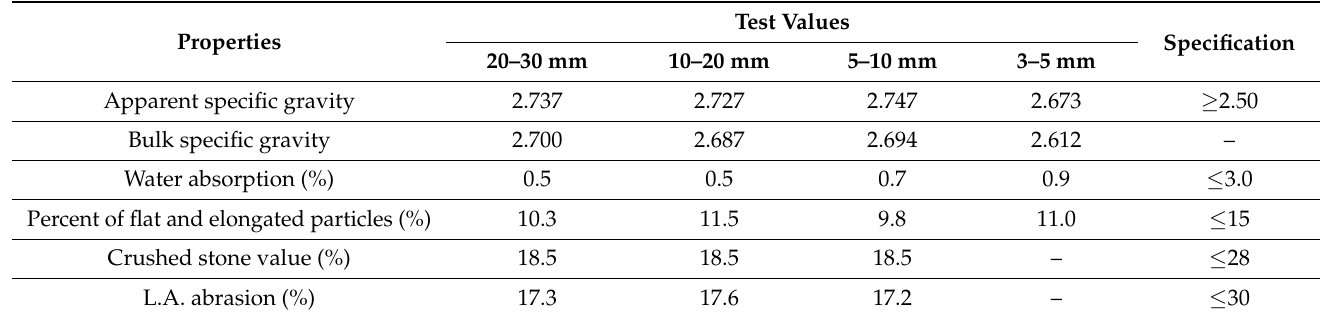
Table 2. Properties of the lime coarse aggregates.